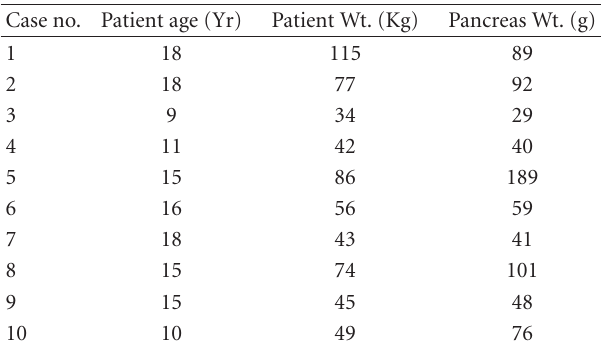
Table 1: Patient age—patient body weight—pancreas